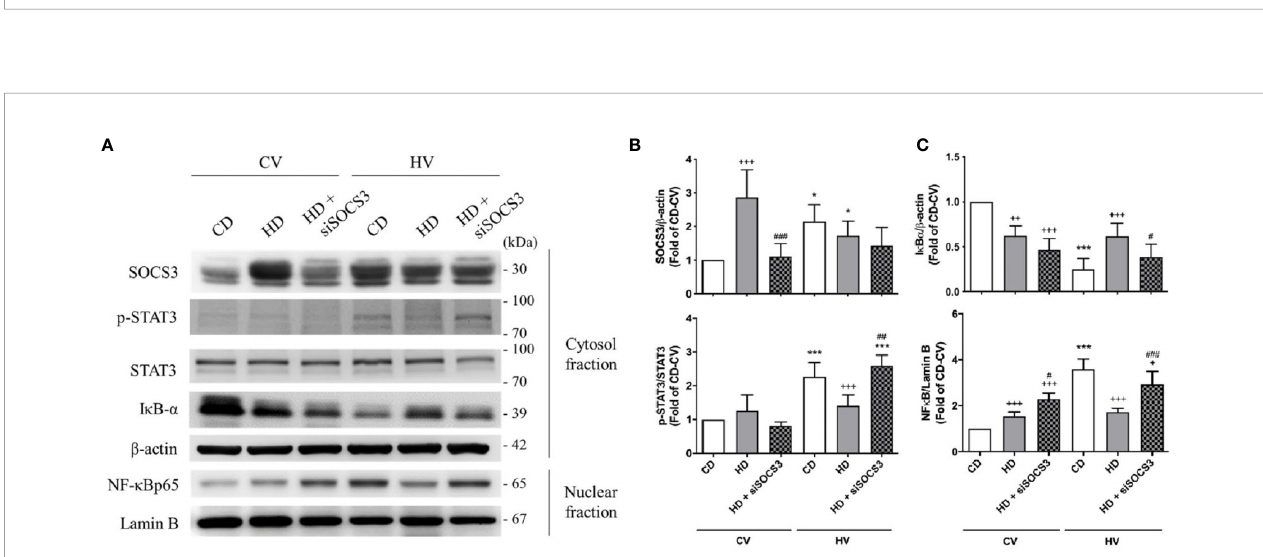
FIGURE 3 | Effects of SOCS3 knockdown on the STAT3 – SOCS3 and NF- k B signaling pathways. These parameters were collected in nonobese mice (CD), obese mice (HD), and obese mice pretreated with an intratracheal spray of a SOCS3 siRNA (HD + siSOCS3) after 6 h of spontaneous breathing (CV) or mechanical ventilation (HV). (A) Western blotting. b -Actin and Lamin B served as loading controls for cytoplasmic and nuclear proteins, respectively. Representative blots are shown. (B) SOCS3 and p-STAT3/STAT3. (C) I k B a and NF- k B. Data are expressed as the mean ± SE (n = 5 per group). * P < 0.05 and *** P < 0.001 compared with the corresponding group in the CV condition. + P < 0.05, ++ P < 0.01, and +++ P < 0.001 compared with the nonobese mouse group (CD). # P < 0.05, ## P < 0.01, and ### P < 0.001 compared with the obese mouse group